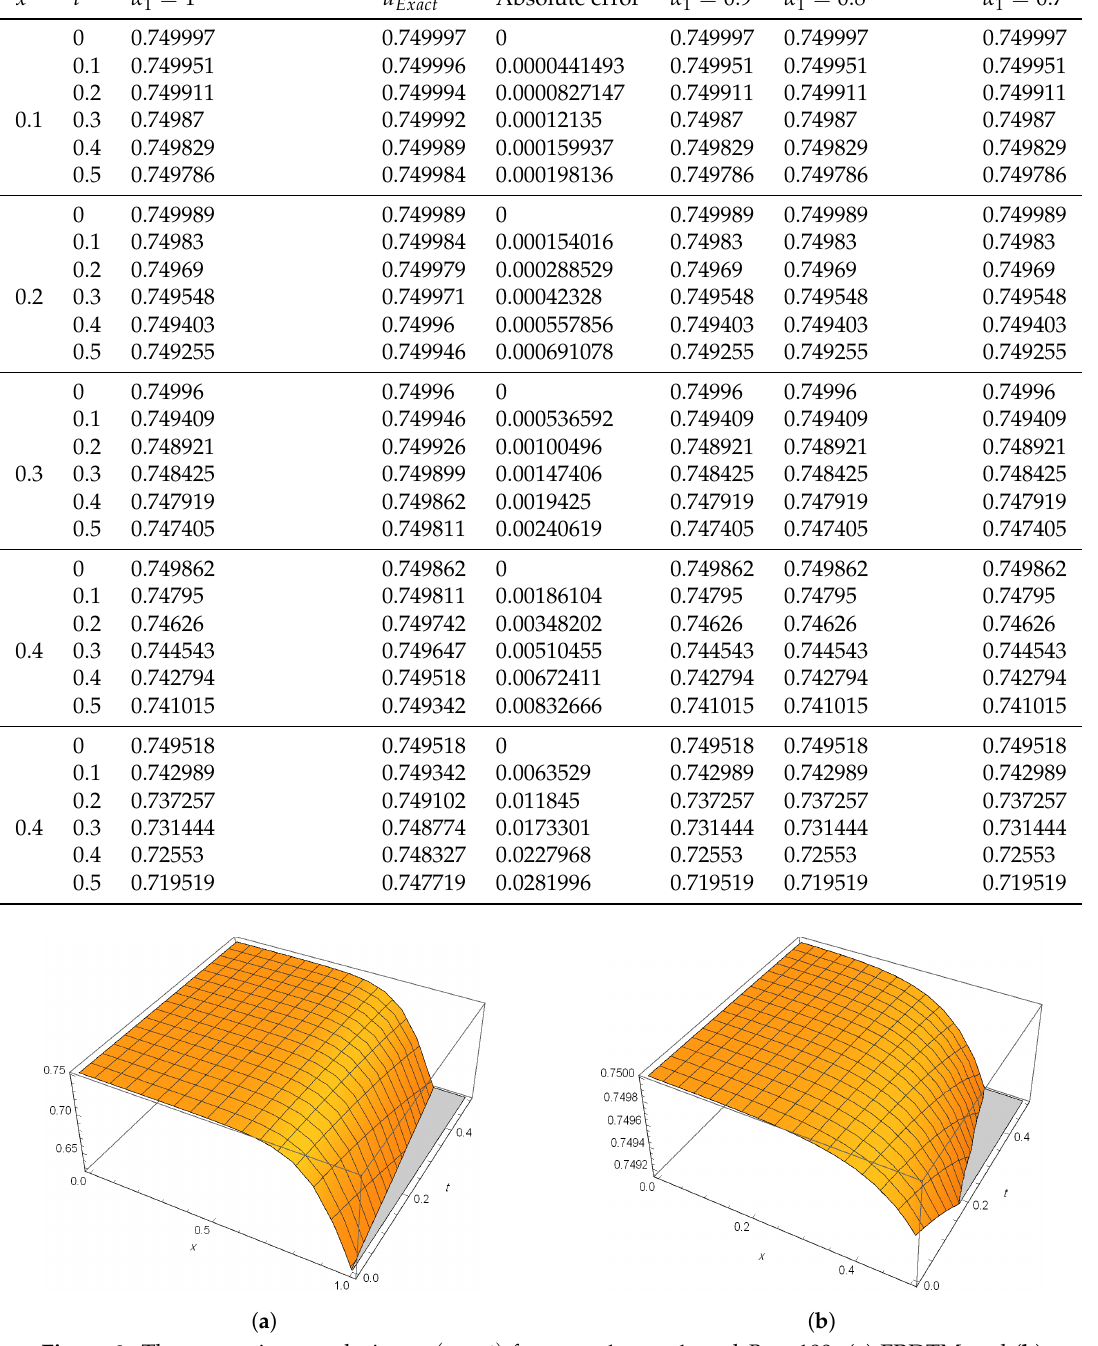
Figure 9. The approximate solution u 4 ( x , y , t ) for α 1 = 1, y = 1, and R = 100: ( a ) FRDTM and ( b ) exact